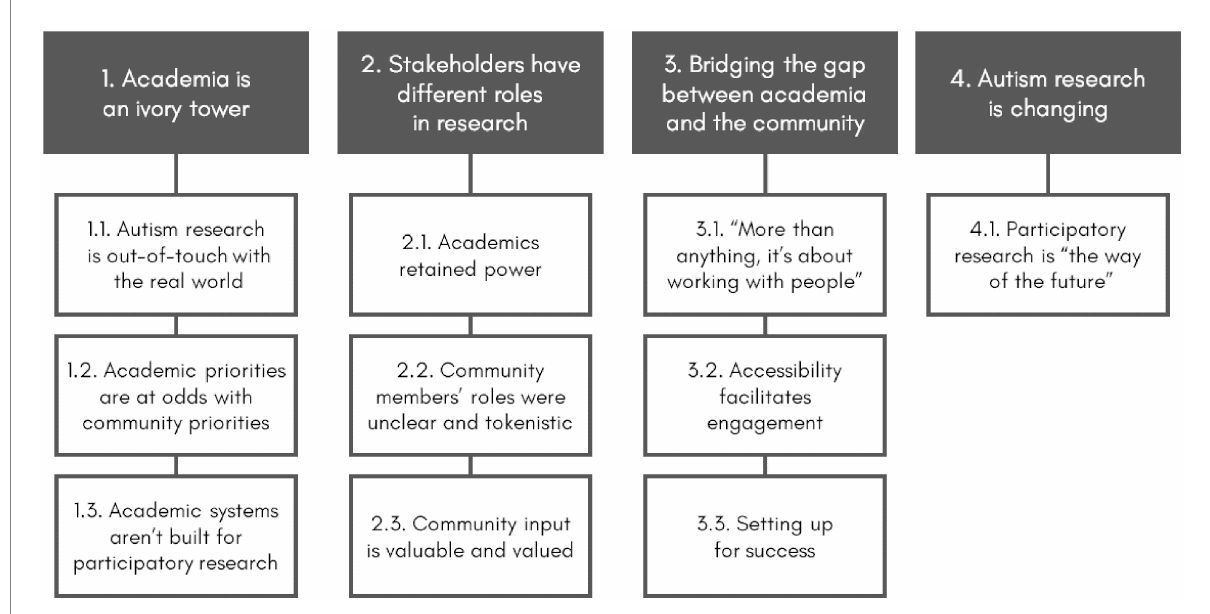
FIGURE 1 Participatory autism research practices and experiences: themes and